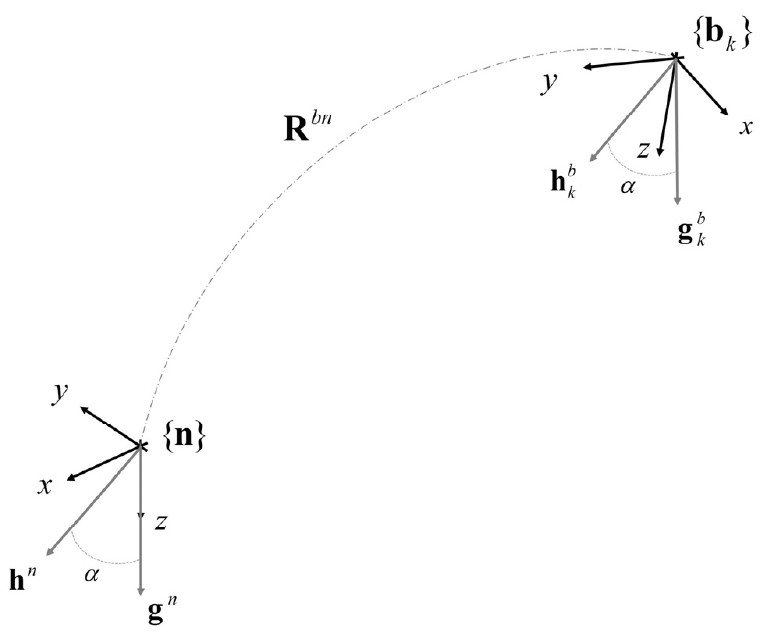
Figure 1. Problem statement: the orientation of { b } with respect to { n } is described by the rotation matrix R bn . The reference vector pairs ( h n , g n ) and ( h b , g b ) are shown in gray. The angle α is defined as the dip angle and it is independent from the reference frame.